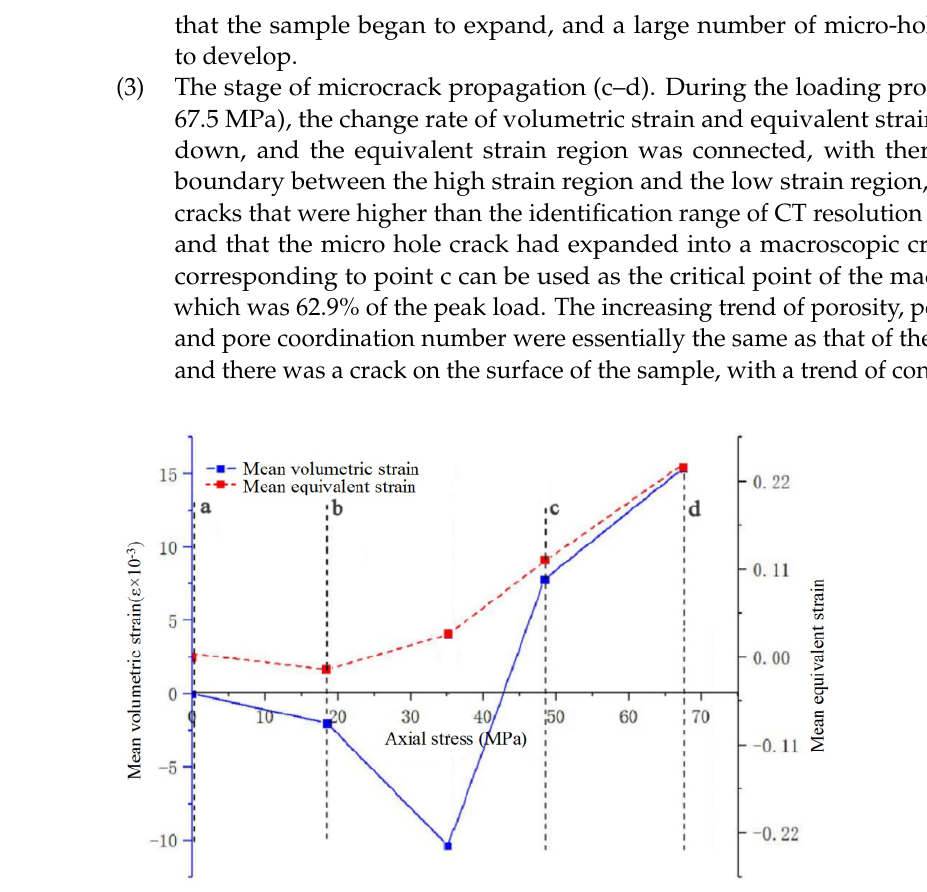
Figure 18. Variation graph of volume strain mean and equivalent strain mean. ( a ) 0MPa. ( b ) 18.5MPa. ( c ) 48.5MPa. ( d ) 67.5MPa.